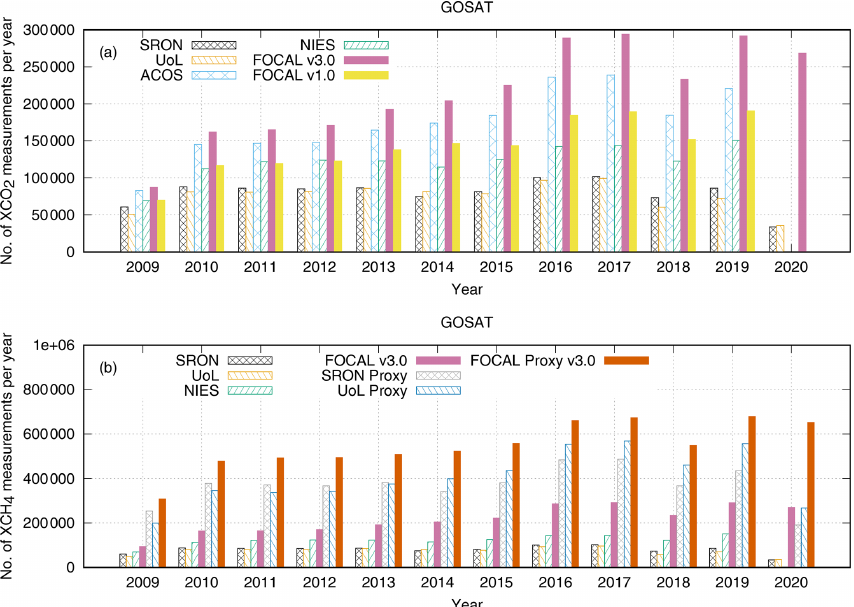
Figure 1. Number of GOSAT data for different products as a function of time (see Table 6 for details on version numbers). (a) GOSAT XCO 2 ; (b) GOSAT XCH 4 .